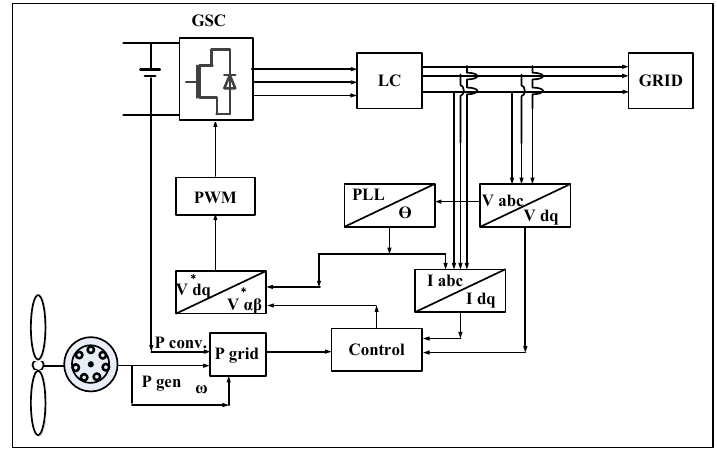
Figure 7. Grid side control block diagram.